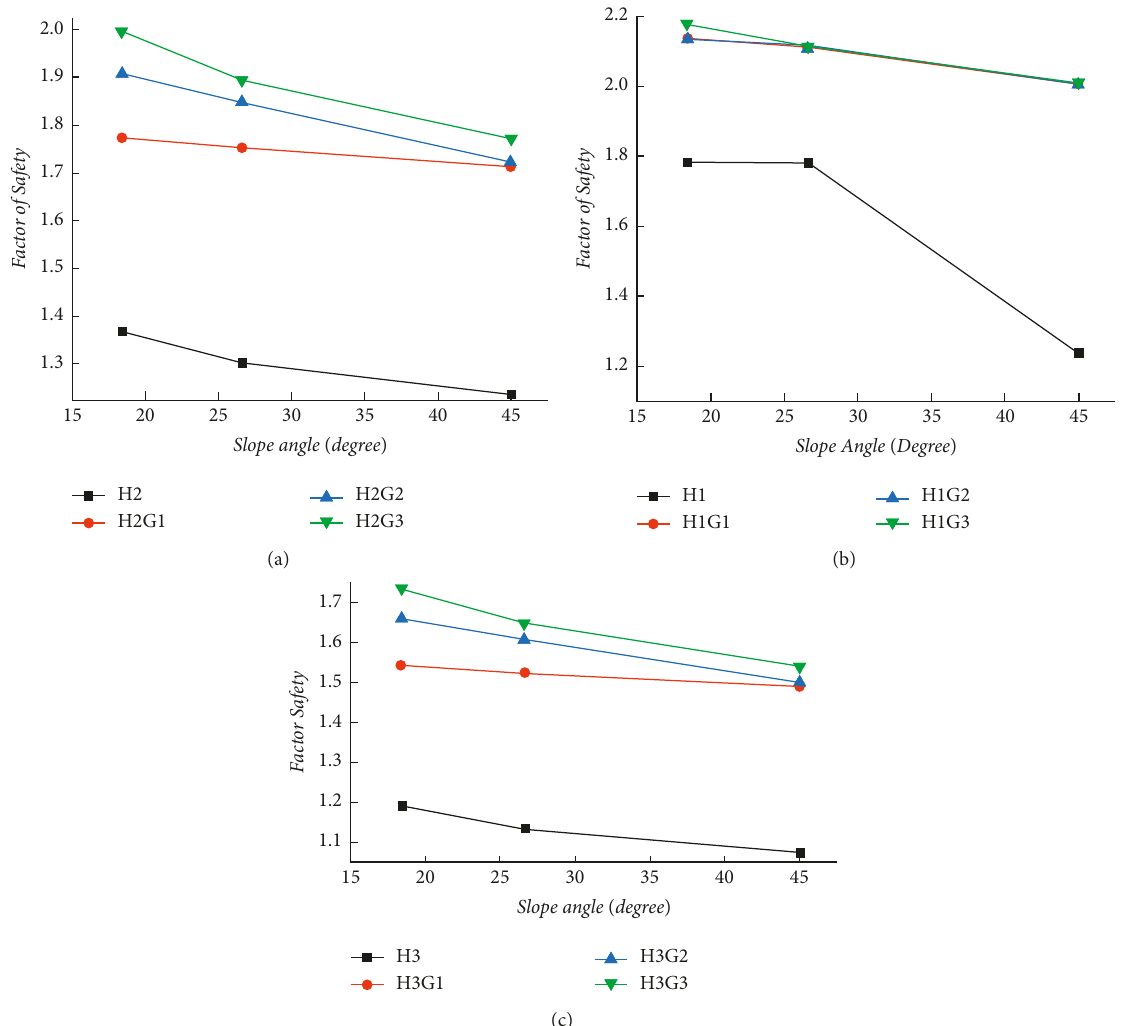
Figure 5: Effects of embankment heights on its stability (a) for H1, (b) for H2, and (c) for